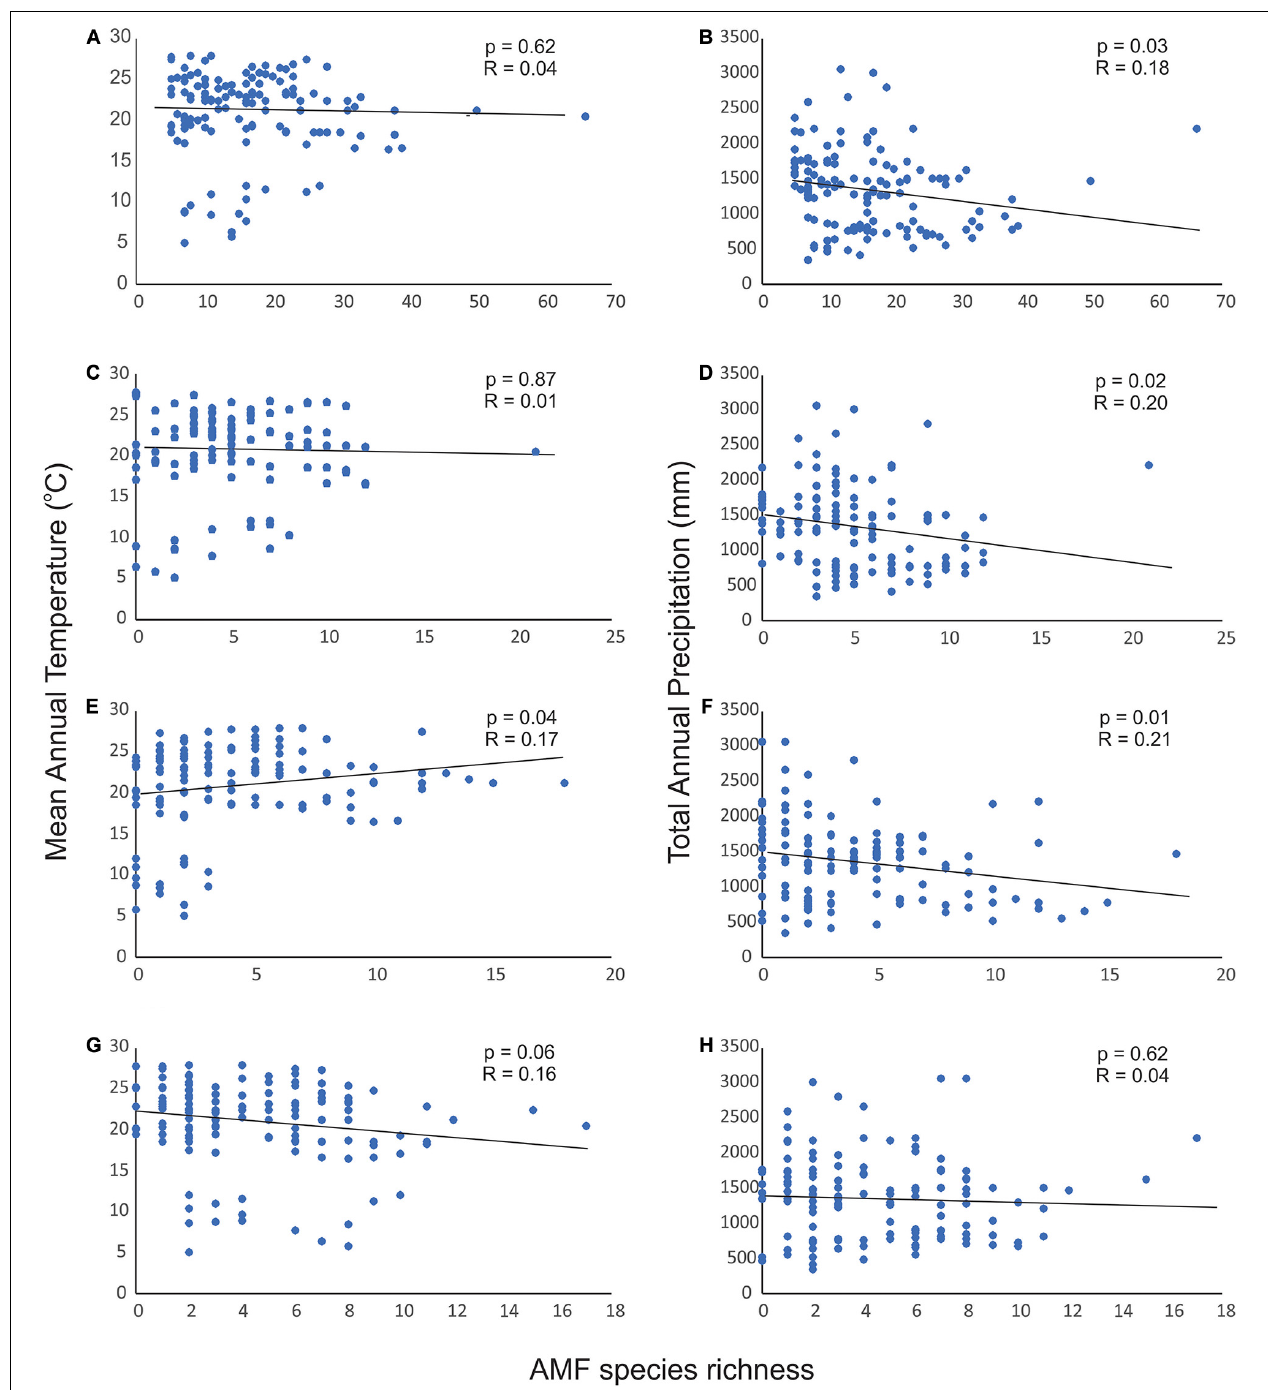
FIGURE 4 | Relationship between mean annual temperature and total precipitation with total AMF species richness (A,B) , richness of Glomeraceae (C,D) , richness of Gigasporaceae (E,F) , and richness of Acaulosporaceae (G,H) in the